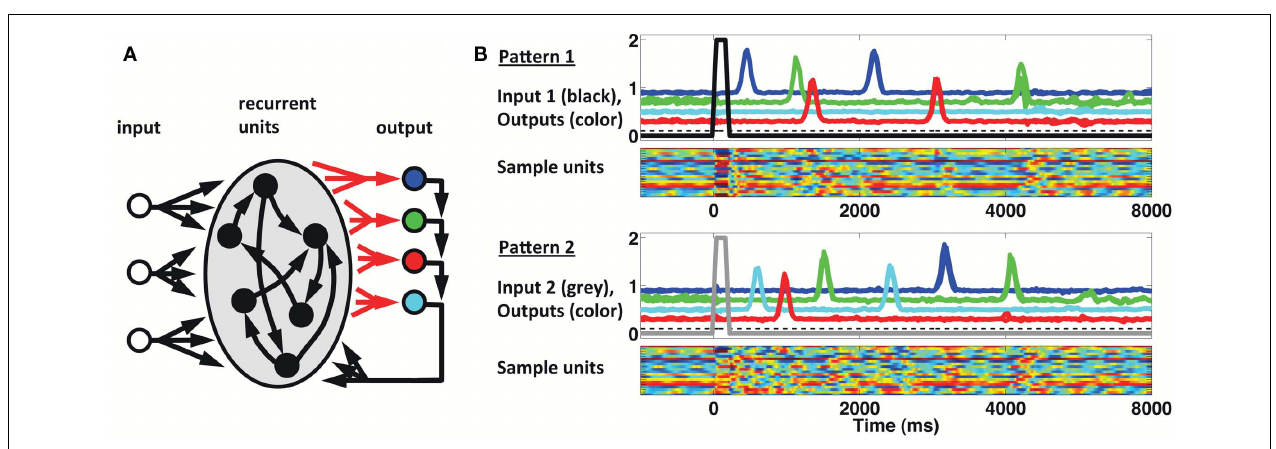
traces are shifted vertically for visual clarity. Each pattern is triggered by a brief activation (100ms) of the corresponding input unit at t = 0 (black thick trace, Pattern 1; gray thick trace, Pattern 2).The dashed black trace represents a (third) constant input to the recurrent network. Colored rasters represent a subset (20) of the recurrent units. In these units activity ranges from − 1 (blue) to 1